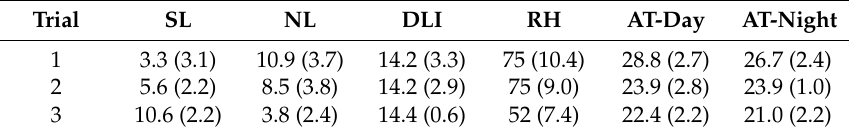
Table 4. Greenhouse conditions (mean and standard deviation (SD)) by trial for supplemental light (SL, moles/m 2 /day), natural light (NL, moles/m 2 /day), daily light integral (DLI, moles/m 2 /day), relative humidity (RH, %), day air temperature (AT-Day, ◦ C), and night air temperature (AT-Night, ◦